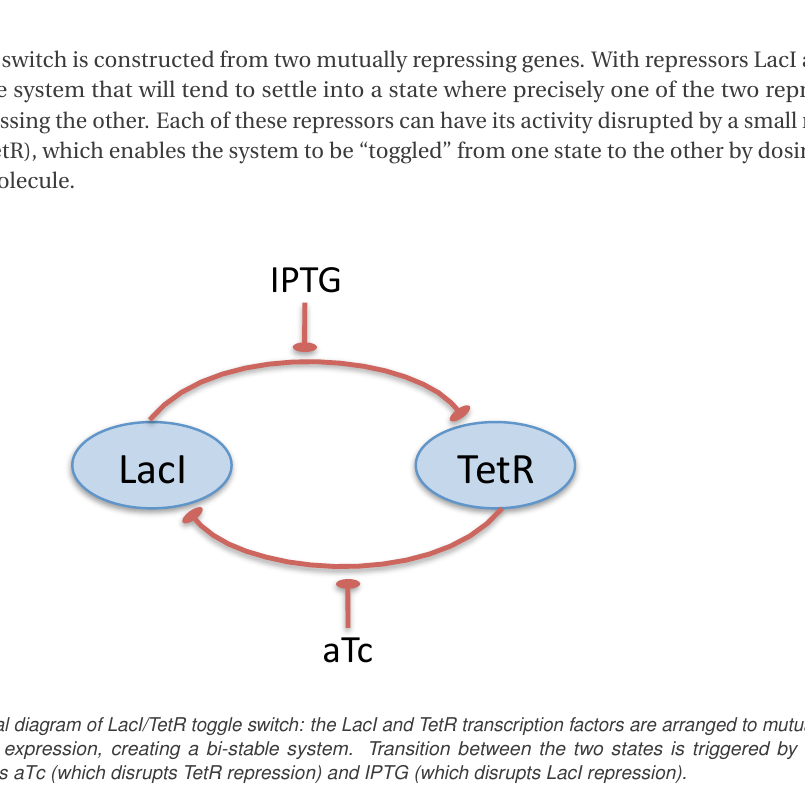
The LacI/TetR toggle switch is modeled in SBOL as two parallel hierarchies of structure and function. The